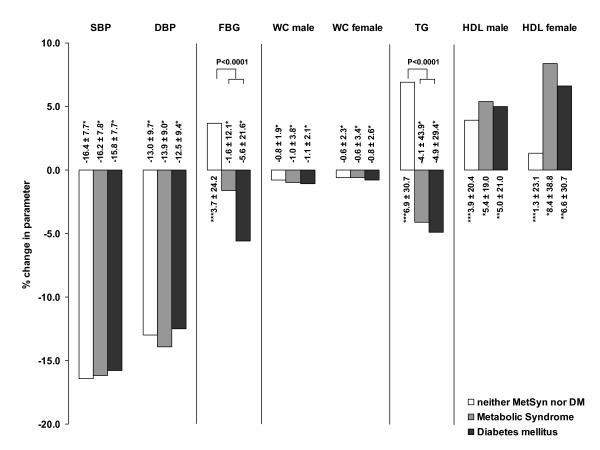
Relative change in the single risk factors and of the metabolic syndrome in total. The Metabolic syndrome is given, if 3 out of 5 criteria are met [17]. Significance: * P < 0.0001; ** P < 0.05; *** P = n.s.; Comparison between groups is a results of ANCOVA analysis (adjusted for age and gender); Differences vs. baseline are compared with a paired t-test (intraindividual comparison).